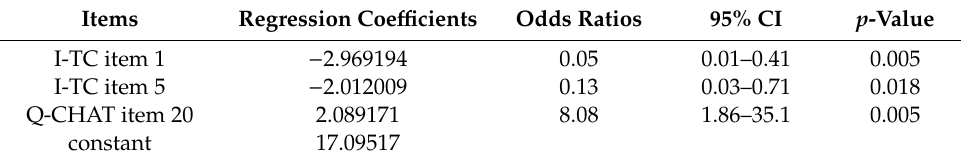
Table 6. Results of the multivariate logistic regression analysis stepdown procedure on the association between diagnosis of ASD or BAP at 36 months and I-TC and Q-CHAT items significantly associated in the final models at 18 months of age (I-TC Items 1 and 5 and Q-CHAT Items 10, 14, 19 and 20). Items Regression Coefficients Odds Ratios